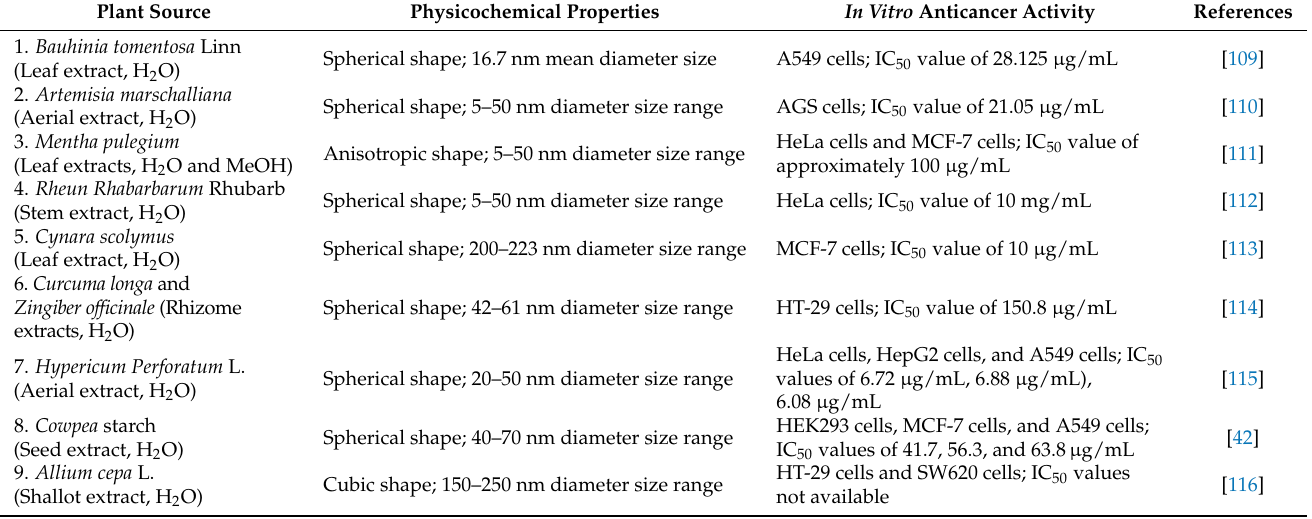
Table 2. Anticancer activity of various biosynthesized silver